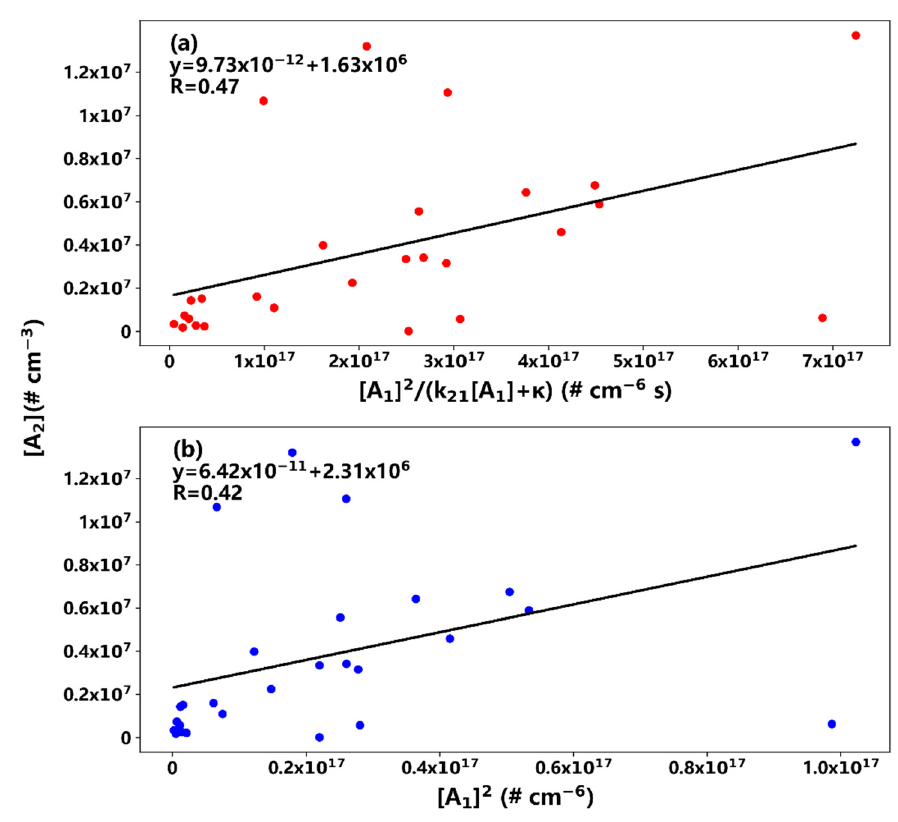
Figure 4. Same as for Figure 3, but for the event on 22 August.